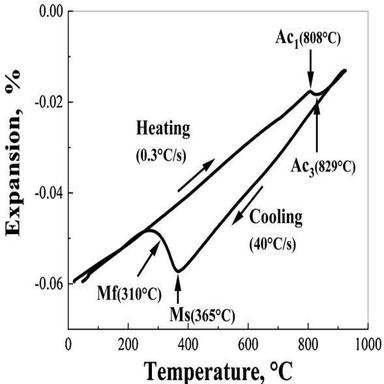
Dilatometric profile of the novel carbide-free 9Cr-ODS steel. The transformation temperatures of Ac1, Ac3, Ms and Mf are indicated by arrows.